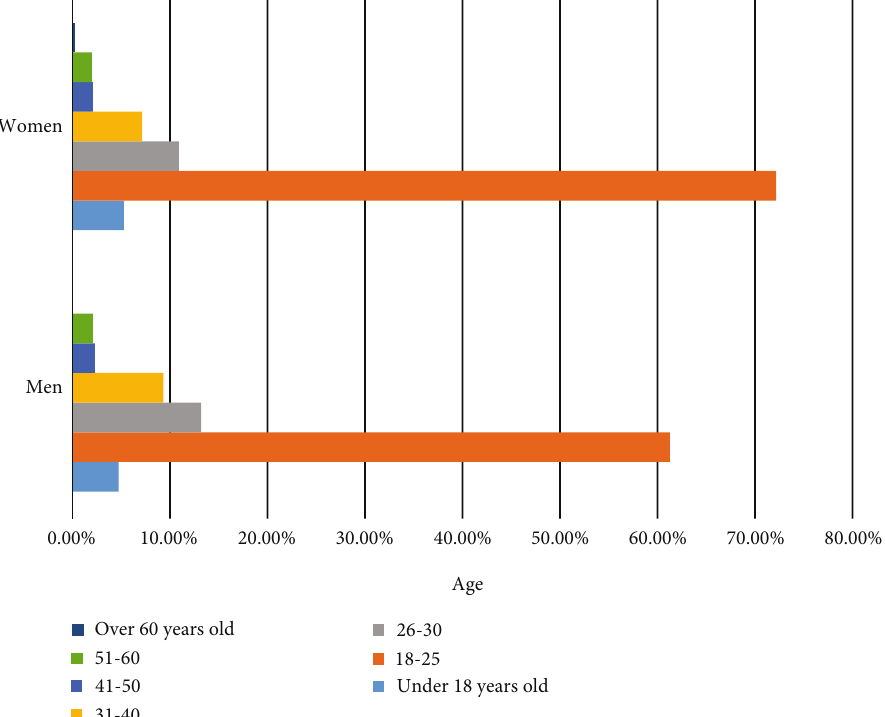
Figure 9: Cognition and preference map of all social personnel on isometric illustration.